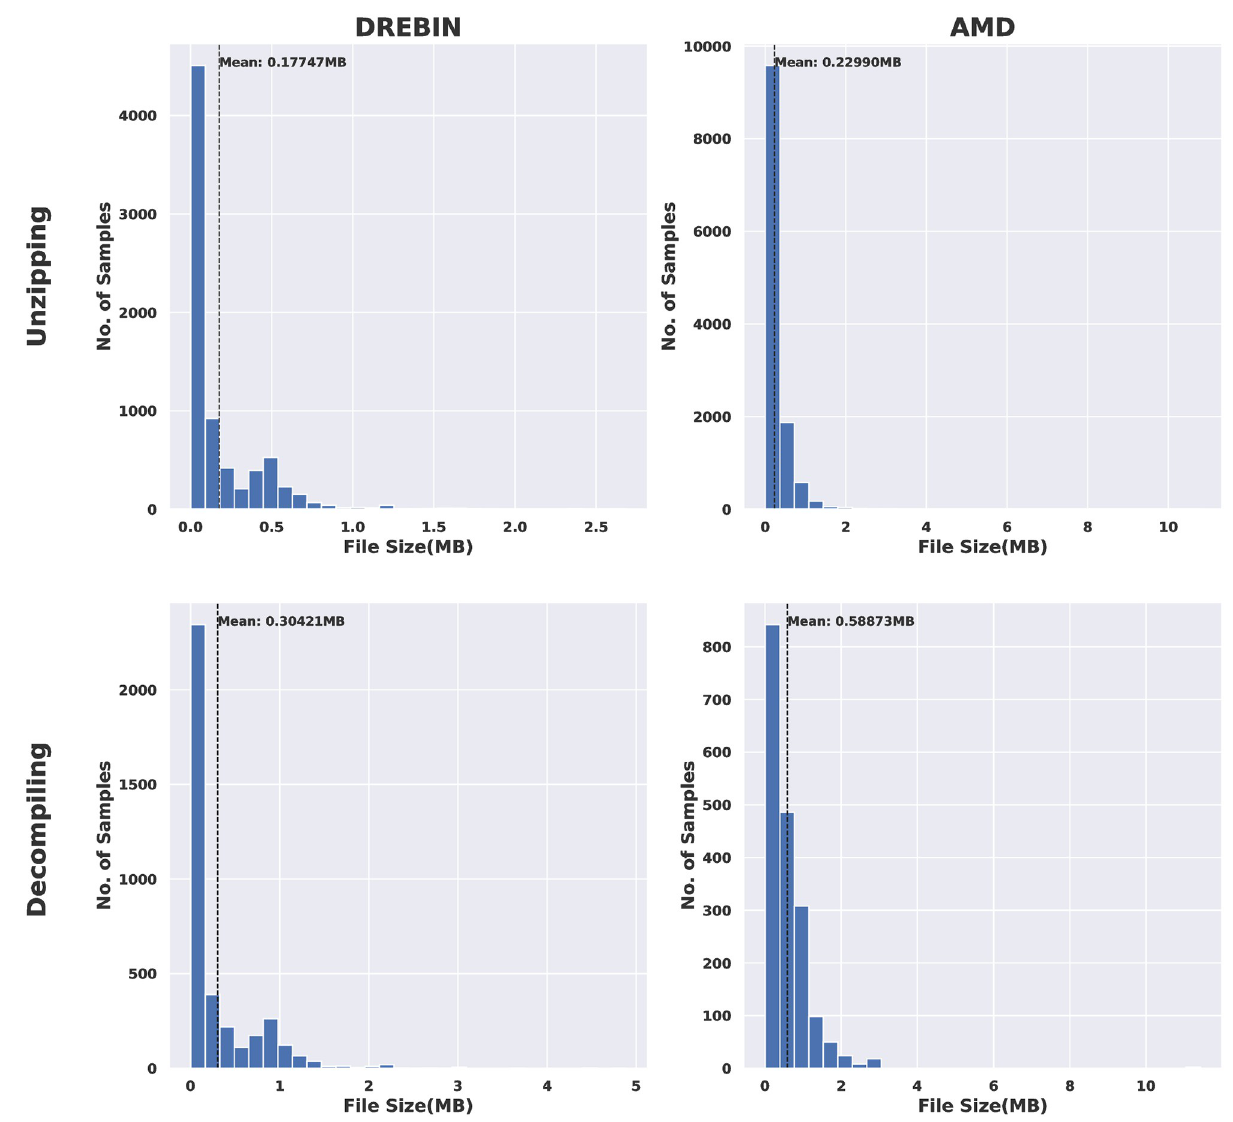
Fig 9. DREBIN VS AMD in terms of file size of CD/SMALI